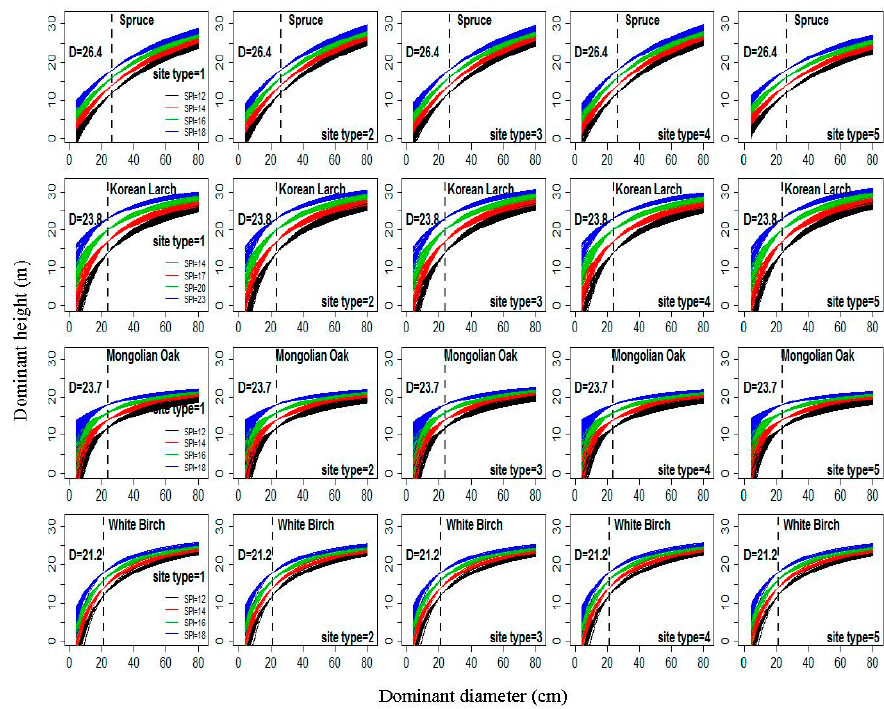
Figure 4. The relationships between dominant height (H) and dominant diameter (D) from Equation (22) under four classes of site productivity index ( SPI ) (12 m, 14 m, 16 m, and 18 m for Spruce, Mongolian Oak, and White Birch, and 14 m, 17 m, 20 m, and 23 m for Korean Larch) according to five different site types (1–5, Table 1) for four natural uneven-aged pure stands of Spruce, Korean Larch, Mongolian Oak, and White Birch; dotted line denotes the dominant heights at the base